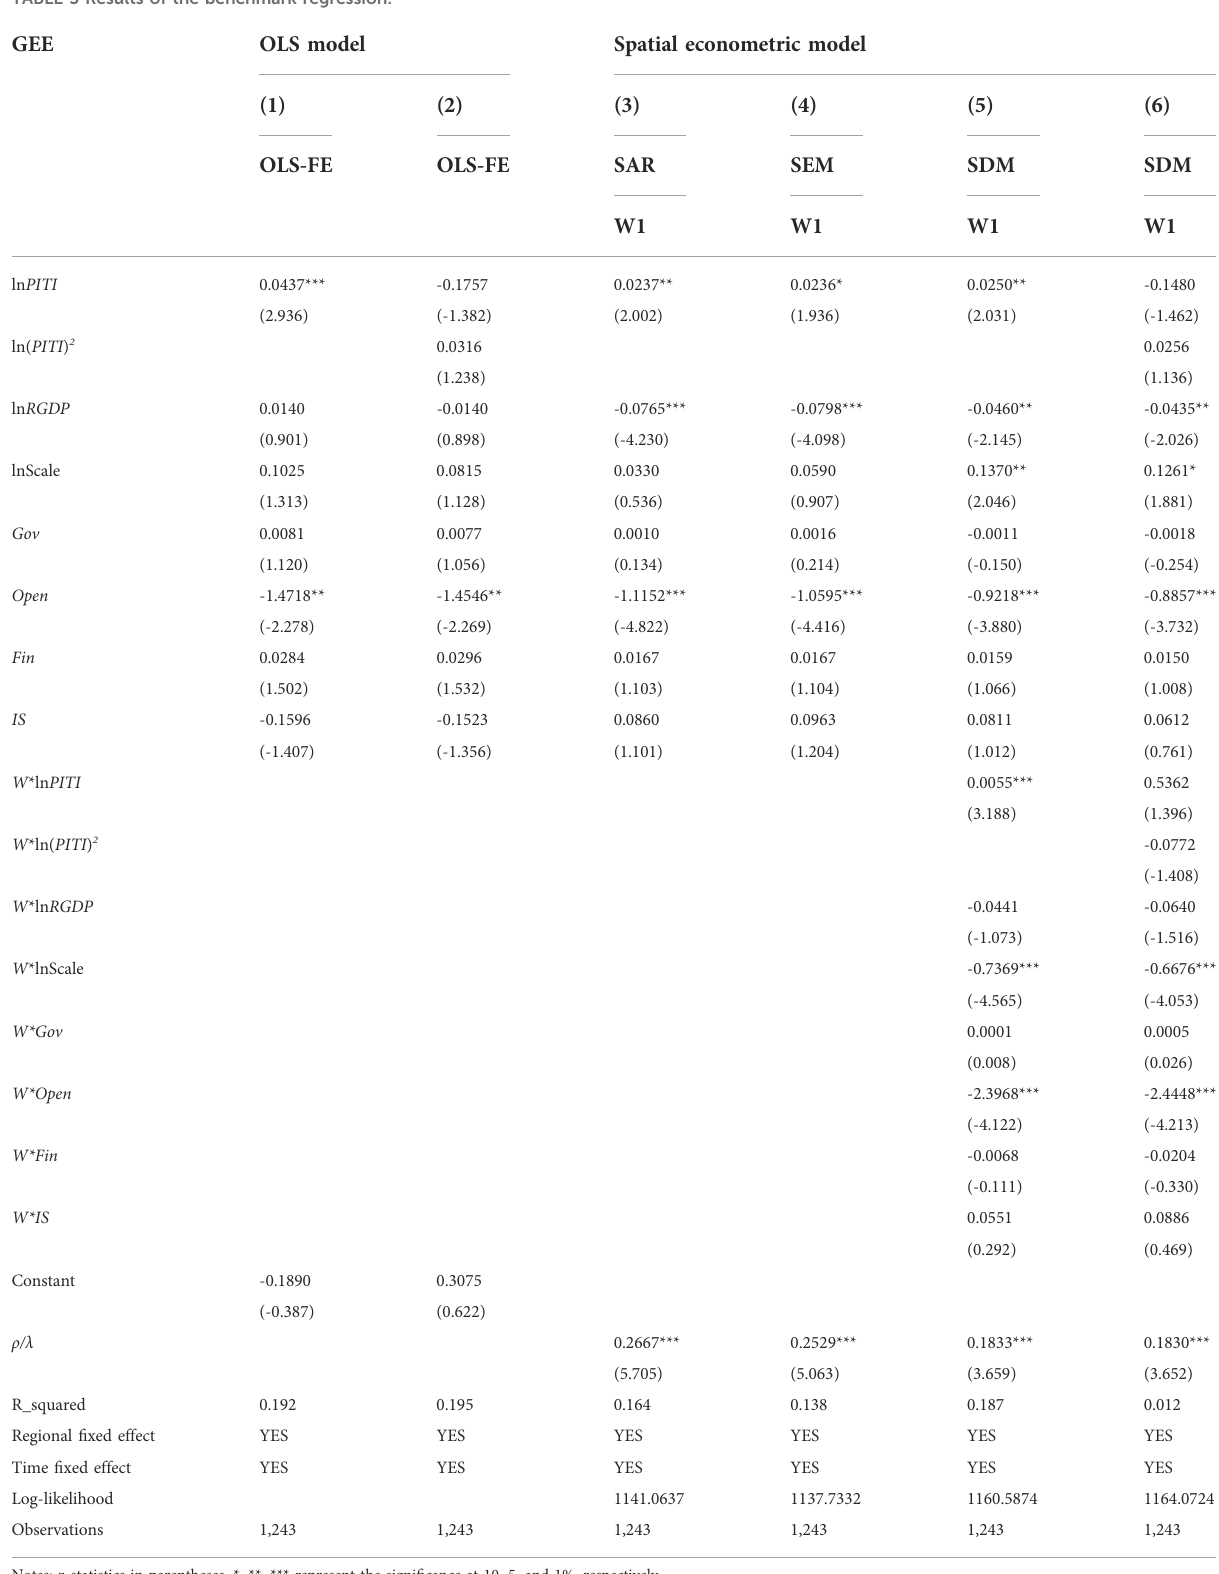
TABLE 5 Results of the benchmark